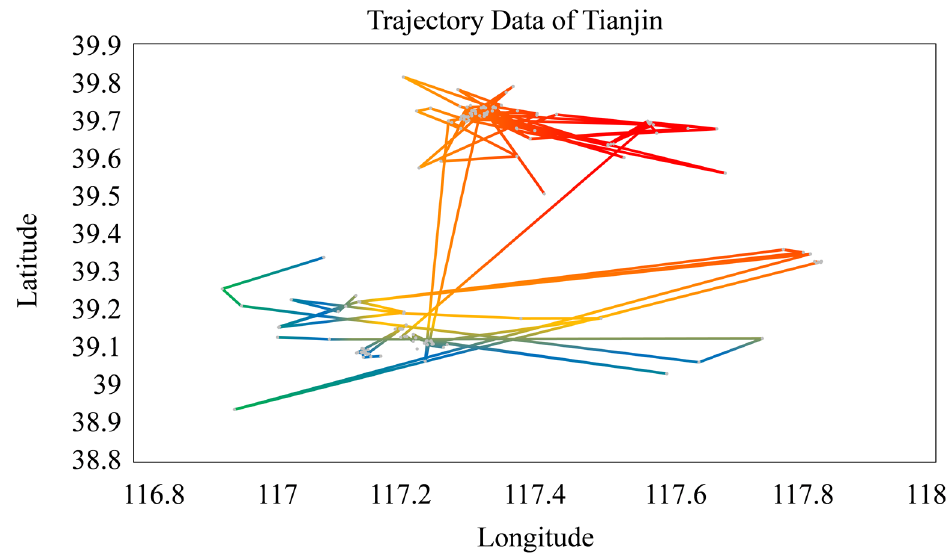
Figure 7. Heat map of trajectory data of Tianjin city.